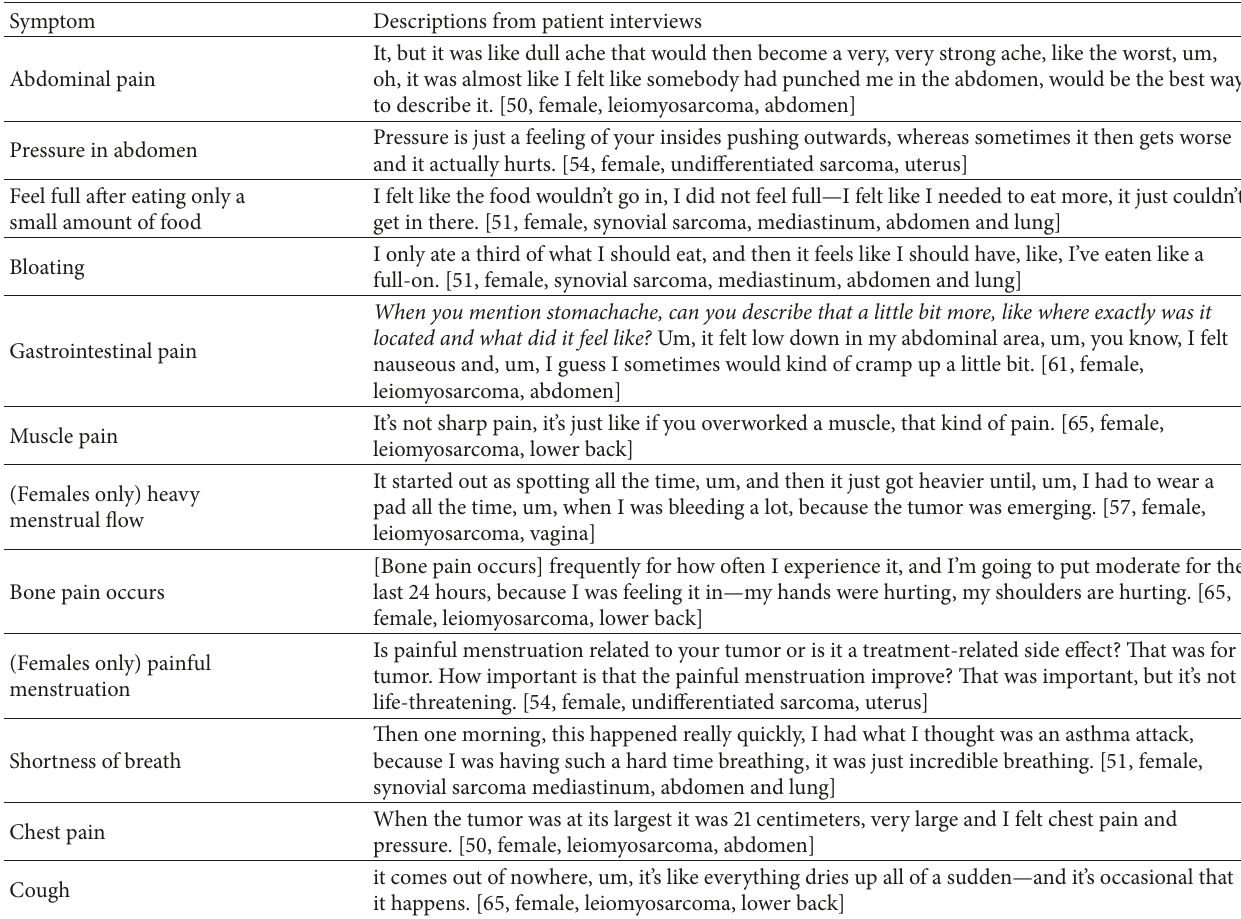
Table 4: Patient descriptions of STS disease symptoms.